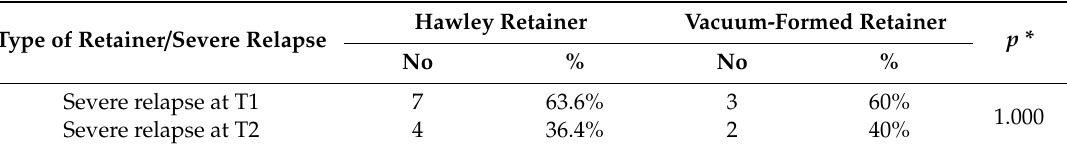
Table 10. Distribution of the patients according to the type of severe relapse and type of retainer.